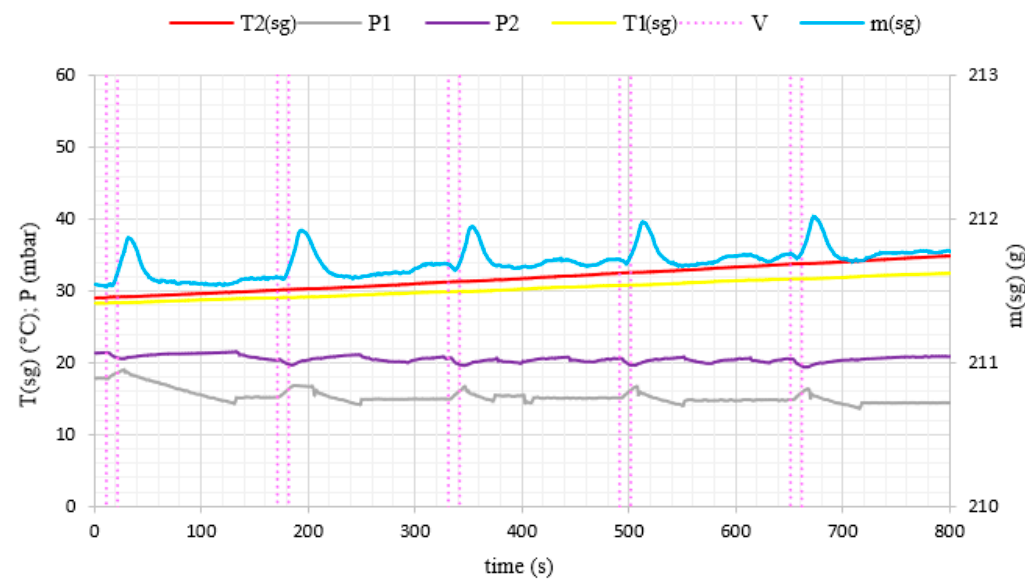
Figure 8. The changes of pressure, temperature and mass of evaporated water with time profiles in the adsorption chamber corresponding to fixed bed conditions (Spherical SG from Fuji Silysia Chemical Ltd.).